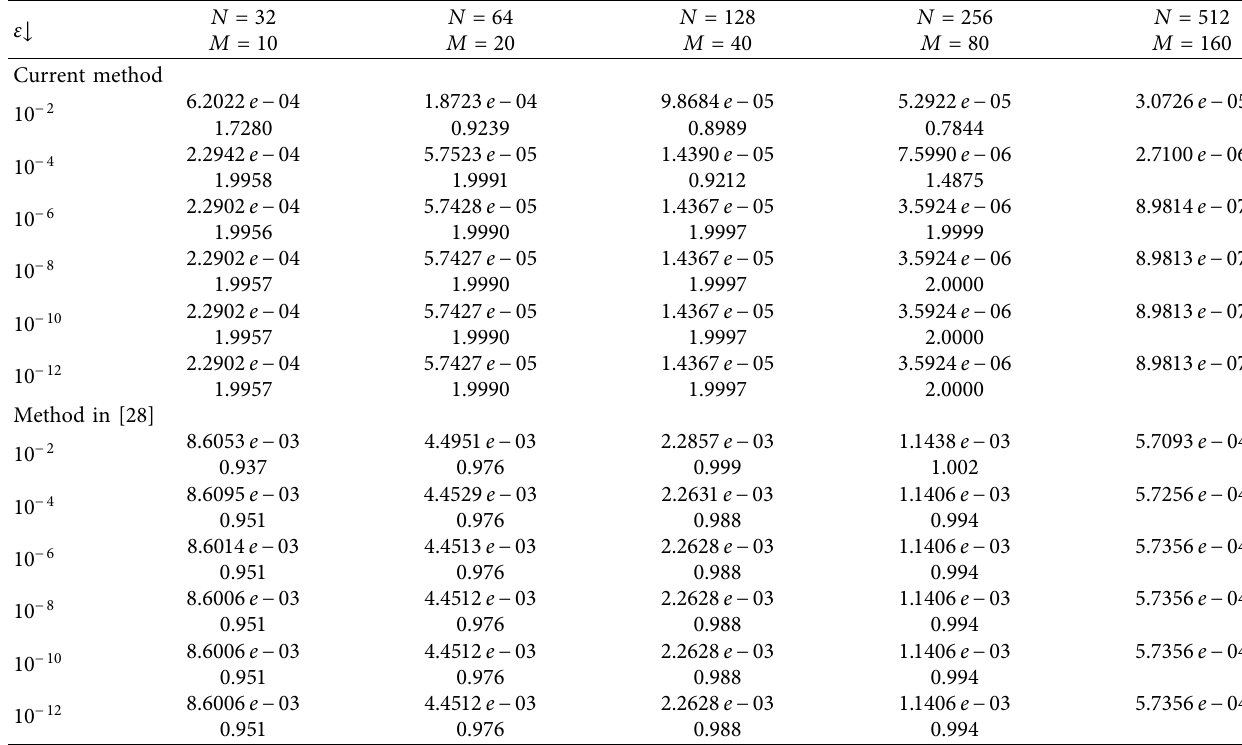
Table 1: Comparison of the maximum pointwise error and rate of convergence for Example 1 for μ � 10 − 6 and different values of ε .